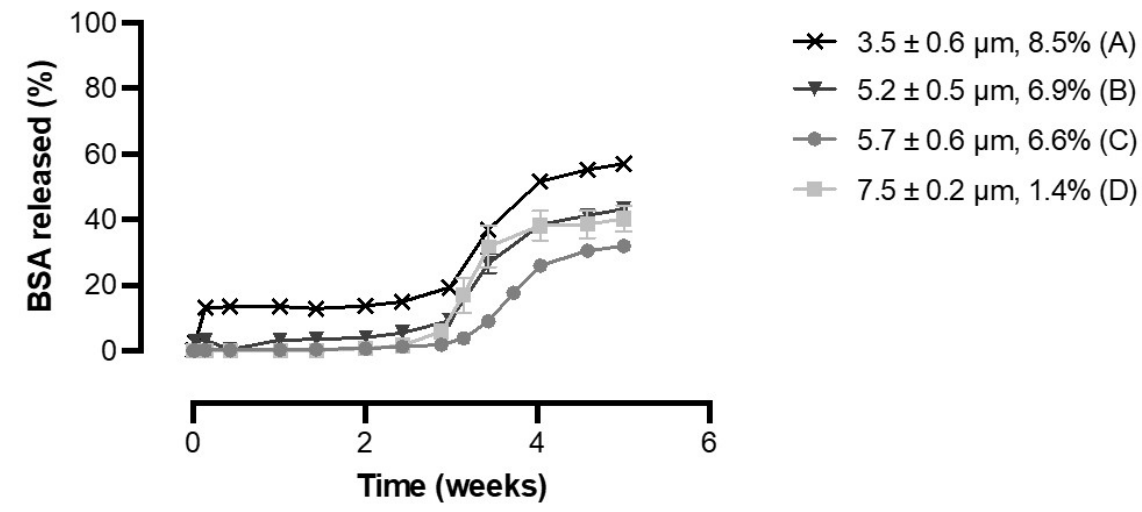
Figure 4. Cumulative in vitro release of BSA from PDLG5002-based core-shell microspheres with different shell thicknesses and BSA loadings ( n = 3).